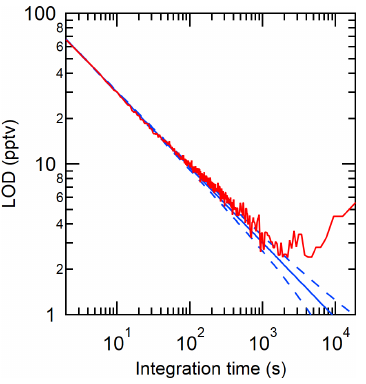
Figure 1. Allan–Werle deviation (3 σ ) in the optical cavity purged with zero air (red line) shown with the ideal deviation (no drift; solid blue line) and associated error in the deviation (dashed blue